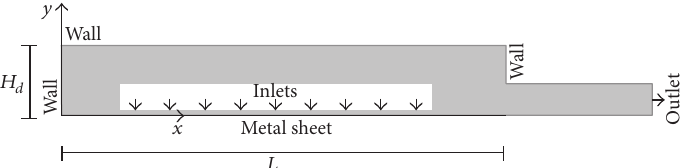
Figure 1: Schematic picture of the computational domain that comprises nine inlets and one outlet; that is, symmetry is applied below the metal sheet. It is possible for the air to flow between the inlets, but the actual geometry of the pipes and nozzles supplying the inlet air is not displayed here due to